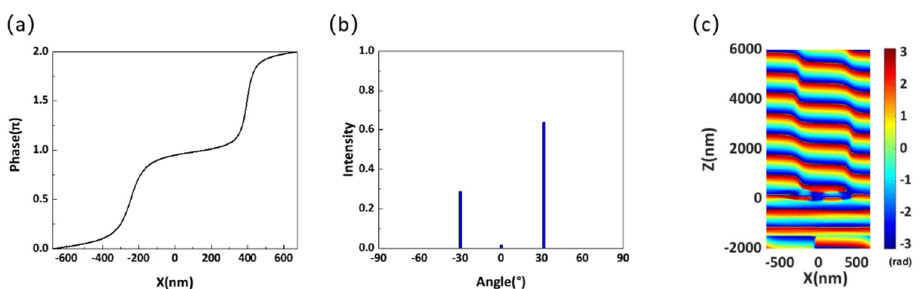
Figure 9. ( a ) Simulated phase distribution along the x-direction at the wavelength of 702 nm with element spacing d = 340 nm. ( b ) Far-field transmission intensity for different diffraction orders at the wavelength of 702 nm. ( c ) Phase distribution of the metasurface with an element spacing of 340 nm at the wavelength of 702 nm.